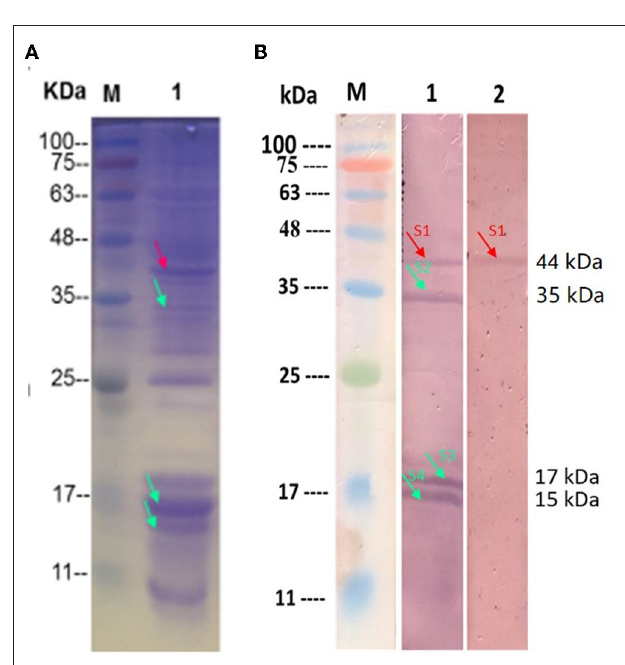
FIGURE 10 | Identification of the surface adhesion proteins in the HC-2. (A) The SDS-PAGA electrophoresis results of HC-2 surface protein; (B) HC-2 surface adhesion protein By Western blot. M: Marker; Line1: The HC-2 surface protein was transferred to PVDF membrane and were incubated with NHS-shrimp membrane protein; Line2: The HC-2 surface proteins were transferred to PVDF membrane and were incubated with NHS-shrimp mucus protein. Unlabeled shrimp intestinal membrane protein and mucus protein were used as negative controls, and no response bands were detected in WB (data not shown in the